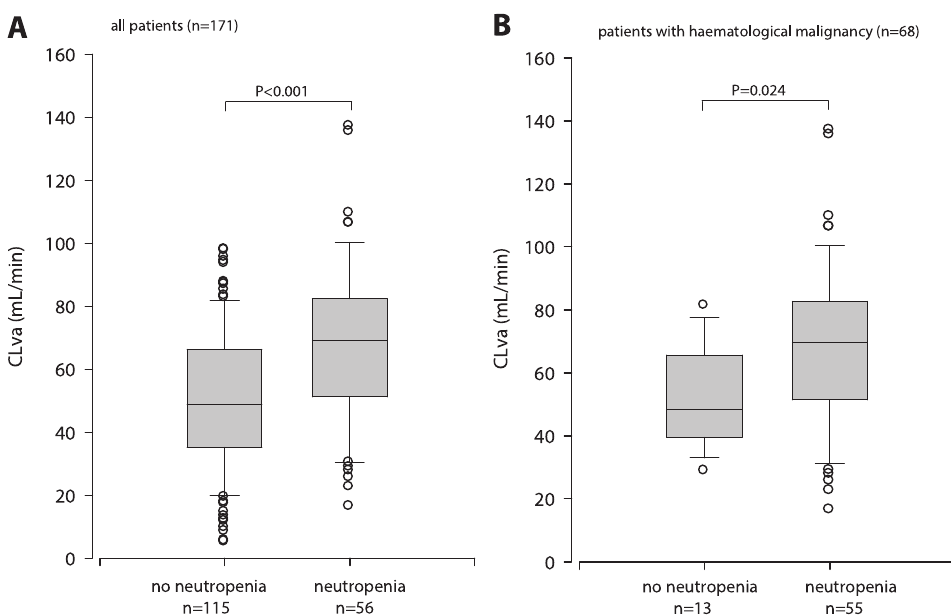
Figure 2. Boxplot for vancomycin clearance (CLva) in patients with and without neutropenia in all patients (A) and in patients with haematological malignancy (B). Lower and higher boundary of the box indicates 25 th and 75 th percentile, respectively, the line within the box marks the median, the whiskers above and below the box indicate the 90 th and 10 th percentiles and the open circles indicate outside the 90 th and 10 th